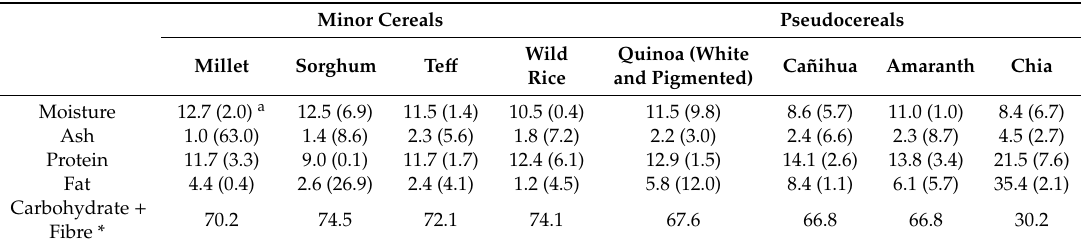
Table 2. Nutritional composition of gluten-free grains (g / 100